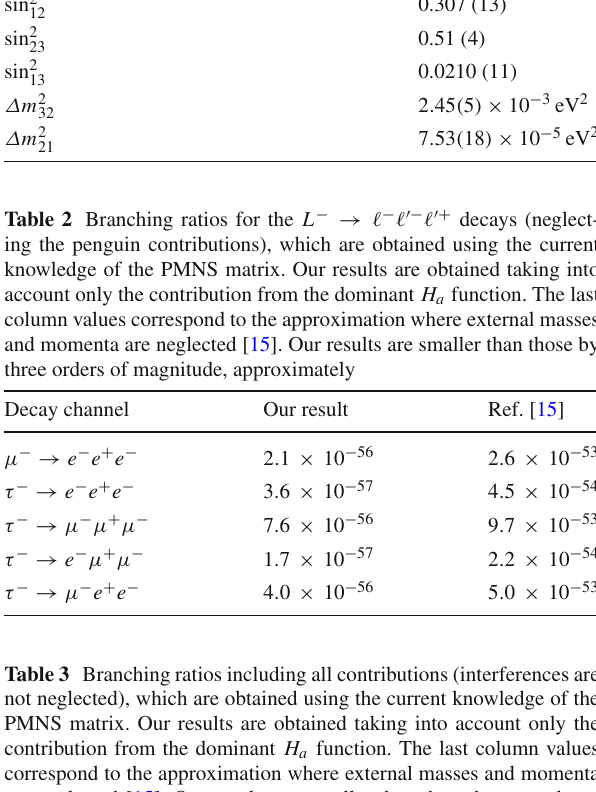
Table 1 Values used for the evaluation of the branching fractions. We also assume a value of m 2 Parameter